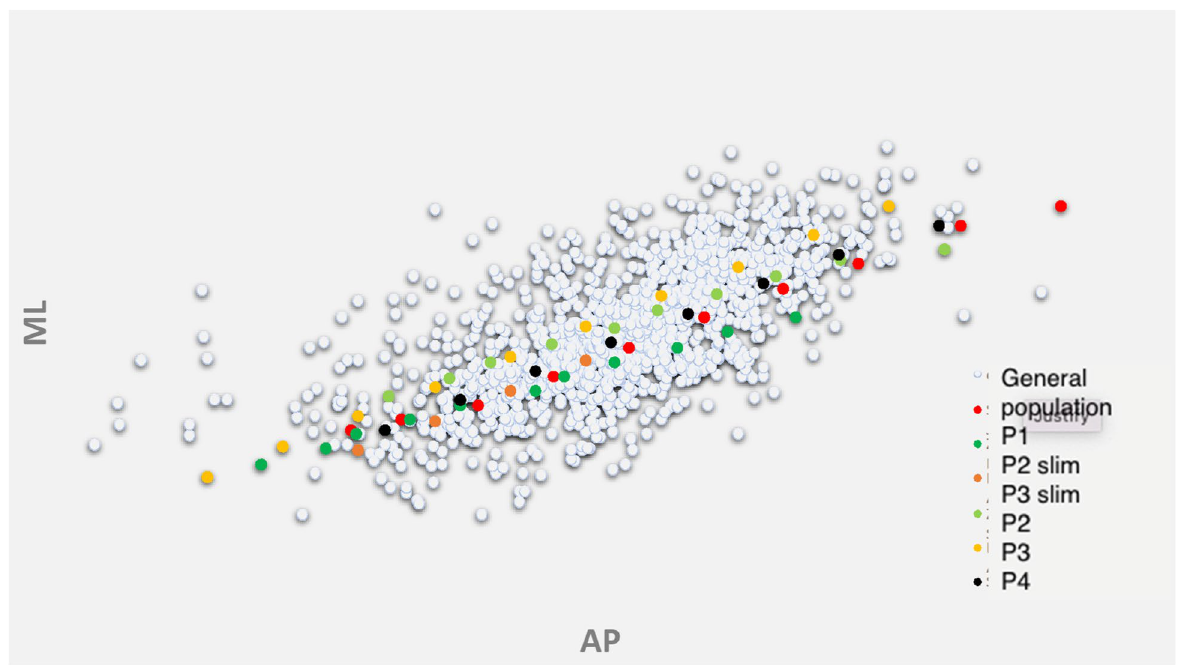
Fig. 6 Coverage offered by off the shelf traditional prostheses. Legend: ML medio-lateral, AP: antero-posterior. Each grey dot depicts a femur and each colored dote an implant